Question: What form of chart is displayed?
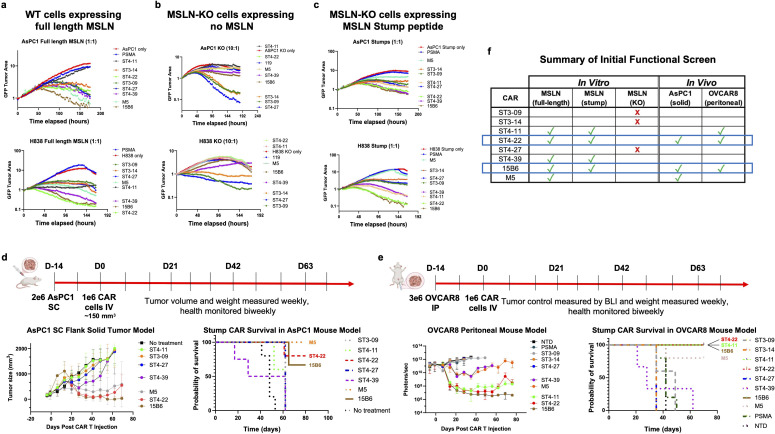
Answer: survival